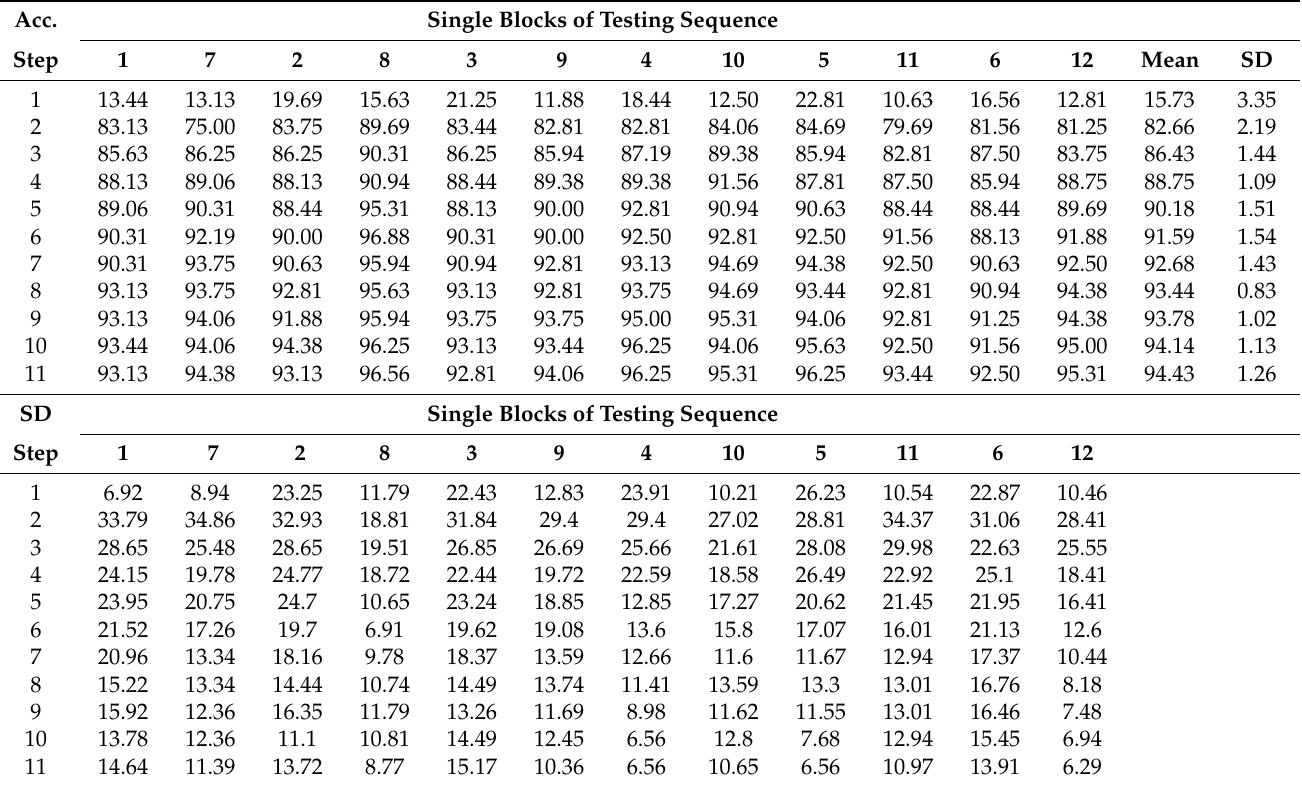
Figure 5. This figure shows the classification accuracy of the bl 12 against models built from all other blocks arranged in the testing sequence ( seq ) = 1, 7, 2, 8, 3, 9, 4, 10, 5, 11, 6. The models were built stepwise added together; the blocks in the seq order, e.g., “1”, “7”, “2”, “8”, etc. represent the models the standard error. Table 2. Averaged accuracy (Acc.) results of the leave-one-out cross-validation of every single block of the testing sequence with the stepwise increasing model (step). Presented are means and SD (bottom table) of all 10 participants. The mean (SD) in the top part are average values for every step.